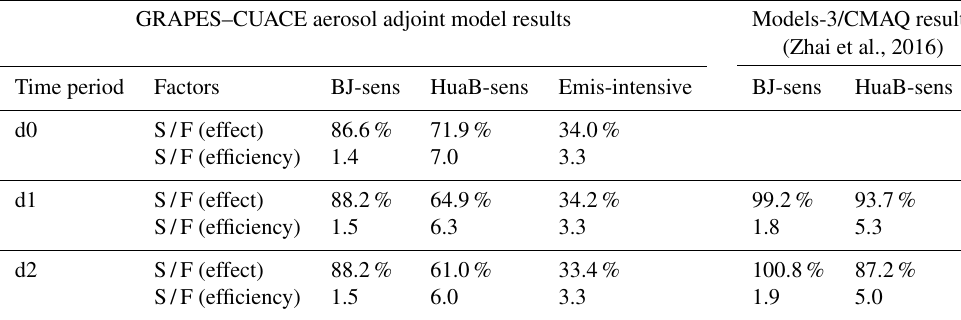
Table 4. Contrast of sensitive (or Emis-intensive) and full region emission source